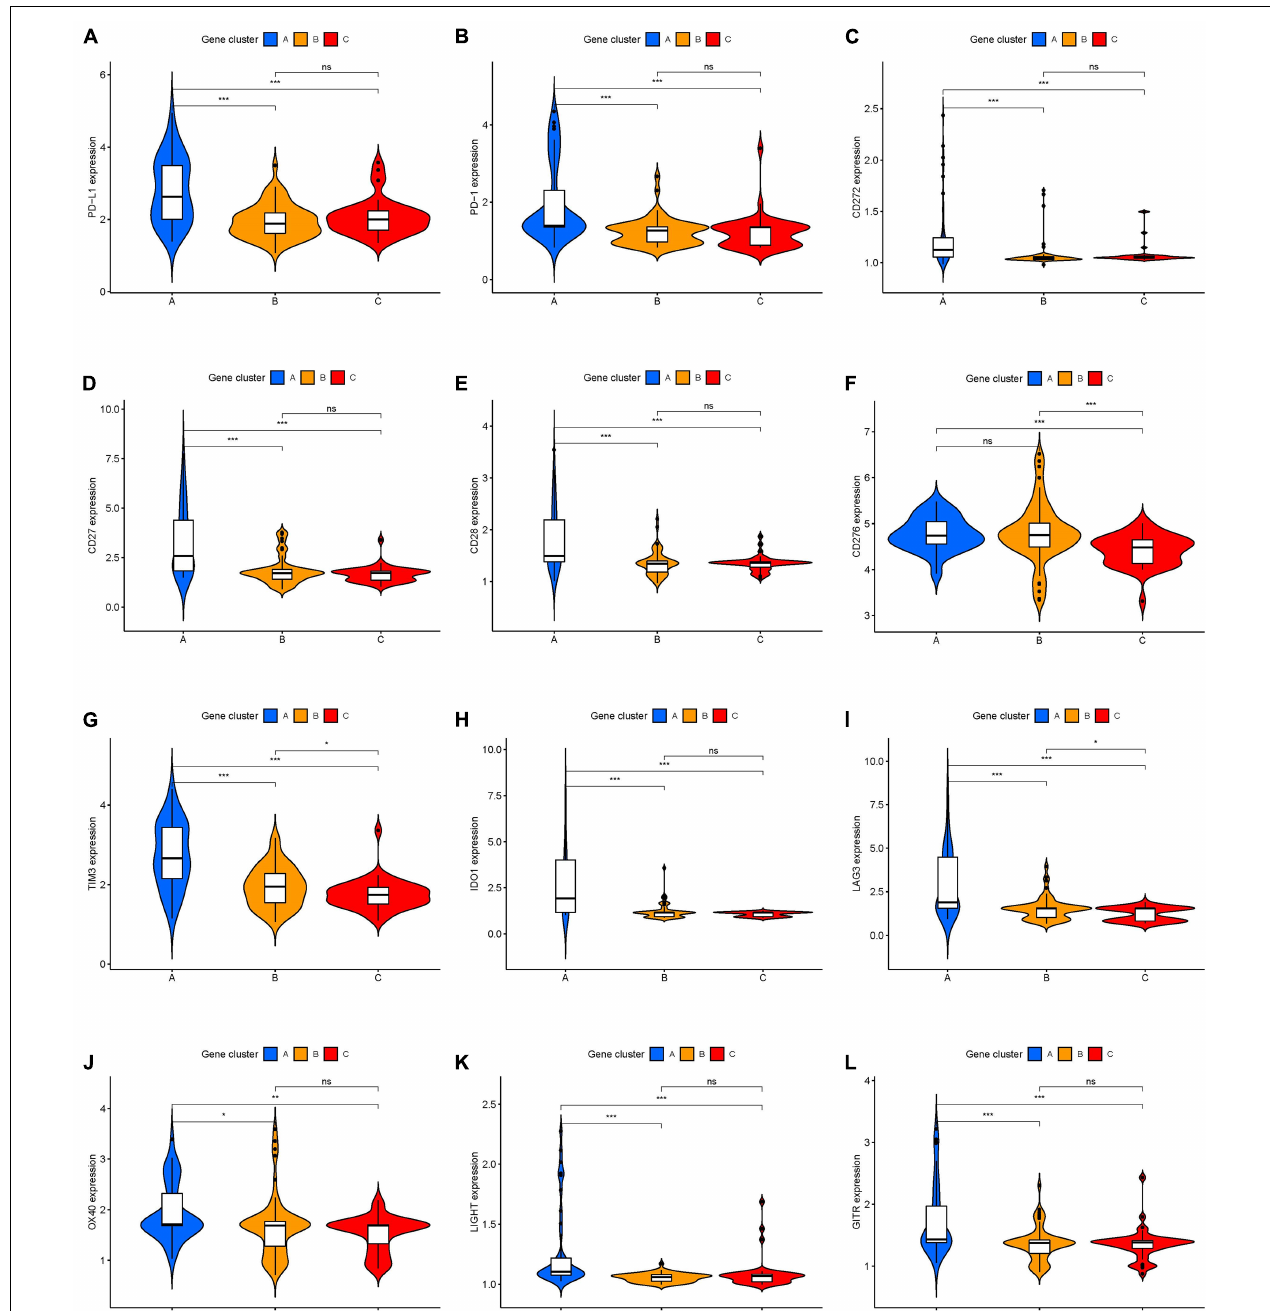
FIGURE 5 | The expression levels of immune checkpoint-related genes in different ICI genes subtypes of UVM. (A) PD-L1. (B) PD-1. (C) CD272. (D) CD27. (E) CD28. (F) CD276. (G) TIM3. (H) IDO1. (I) LAG3. (J) OX40. (K) LIGHT. (L) GITR. ns, not significant; * p < 0.05; ** p < 0.01; and *** p < 0.001. UVM, uveal